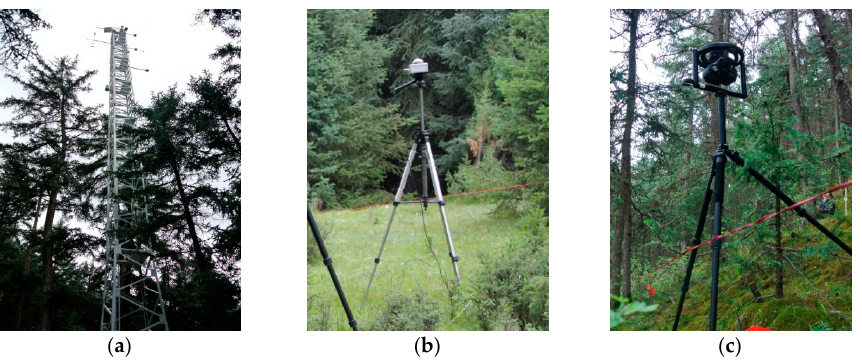
Figure 3. Field measurements at Dayekou: ( a ) The pylon with the photon flux sensor; ( b ) SunScan; ( c ) Hemiview.